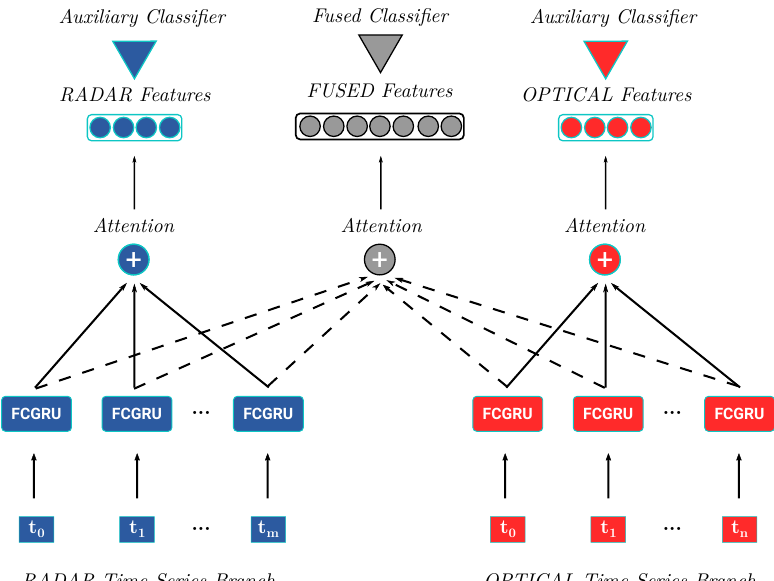
Figure 6. Overview of the HOb2sRNN method. The architecture is composed of two branches, one for each source (radar and optical) SITS. Each branch processes the SITS by means of an enriched RNN cell we named FCGRU and an attention mechanism is employed on its outputs to extract the per source features. Furthermore, the same attention mechanism is employed on the concatenation of the per source outputs allowing to extract fused features. Finally, the per-source and fused feature sets are leveraged in order to provide the final